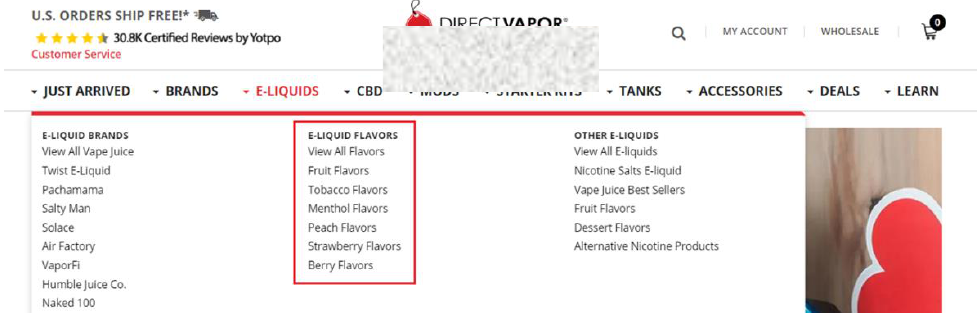
Figure A1. An Example of E-liquid Flavor Filters, i.e., Flavor Options of E-liquids Sold by Store 1 (Location of E-liquid Filters Highlighted by Square Bracket) Table A1. E-liquid Flavors: Main Categories, Subcategories, and Key Terms. Main Category (-Subcategory)